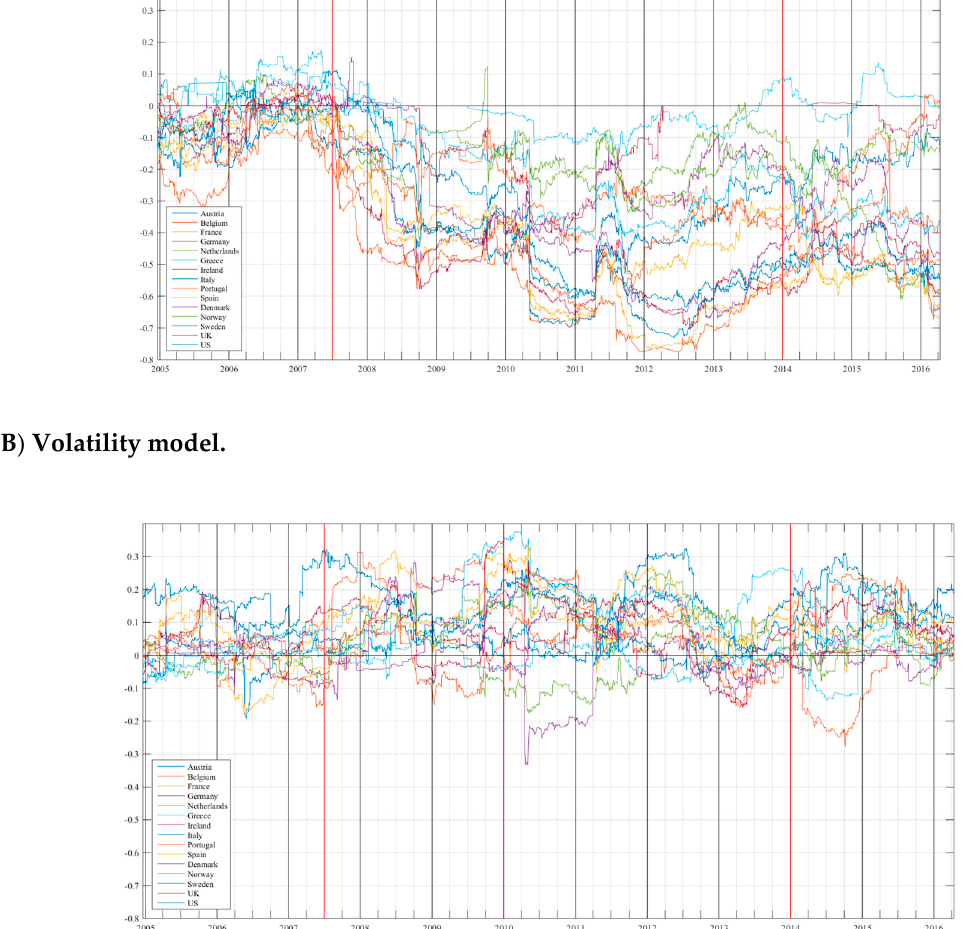
Figure 7. Daily time evolution of the correlation coefficients of the European and US stock financial and CDS returns ( Panel ( A )) and financial stock index conditional volatility and CDS returns ( Panel ( B )) using 250-day rolling windows. The sample period is from 1 January 2004 to 4 April 2016. The vertical red lines mark the beginning of the different sub-periods: global financial crisis, Eurozone sovereign debt crisis and post-crisis period.